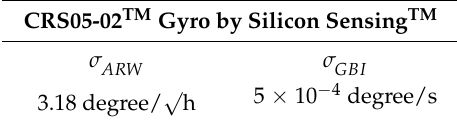
(TCZUPT filter). GBI